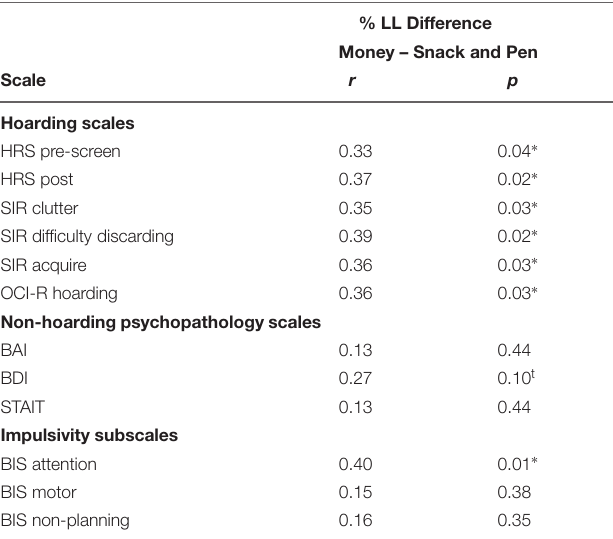
TABLE 5 | Correlations of psychopathology measures with the main effect of the intertemporal discounting task (ITD). % LL